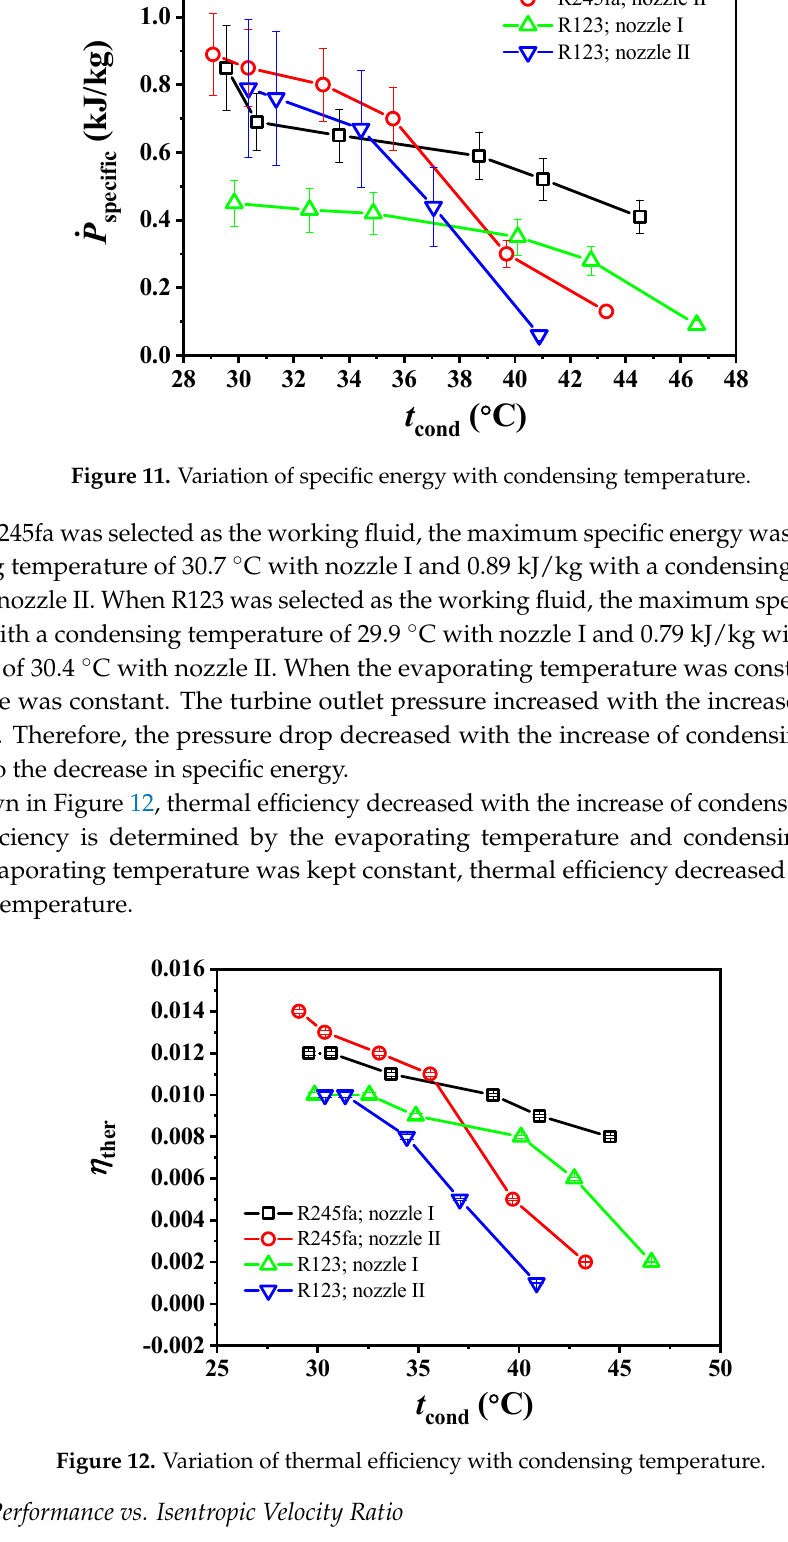
Figure 12. Variation of thermal efficiency with condensing temperature.